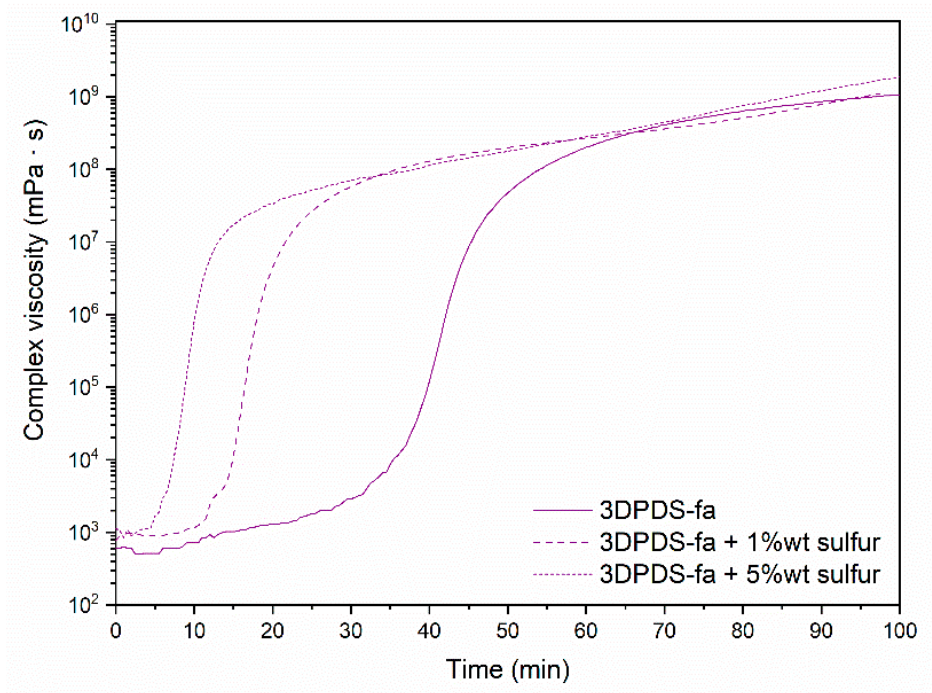
Figure A26. Curing behavior of 3DPDS-fa with 0, 1, and 5 %wt of sulfur by rheo-kinetics measurement at 150 °C followed by complex viscosity over time.